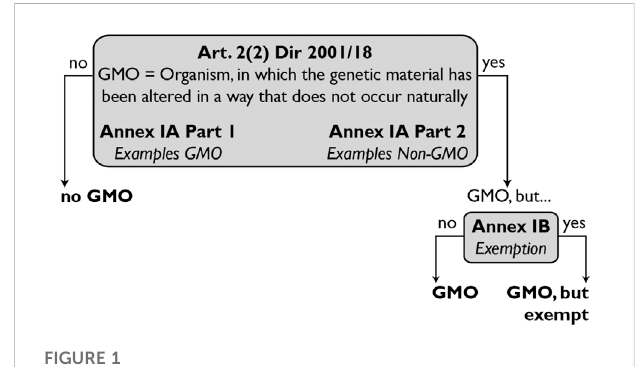
FIGURE 1 The EU ’ s de fi nition of a GMO.